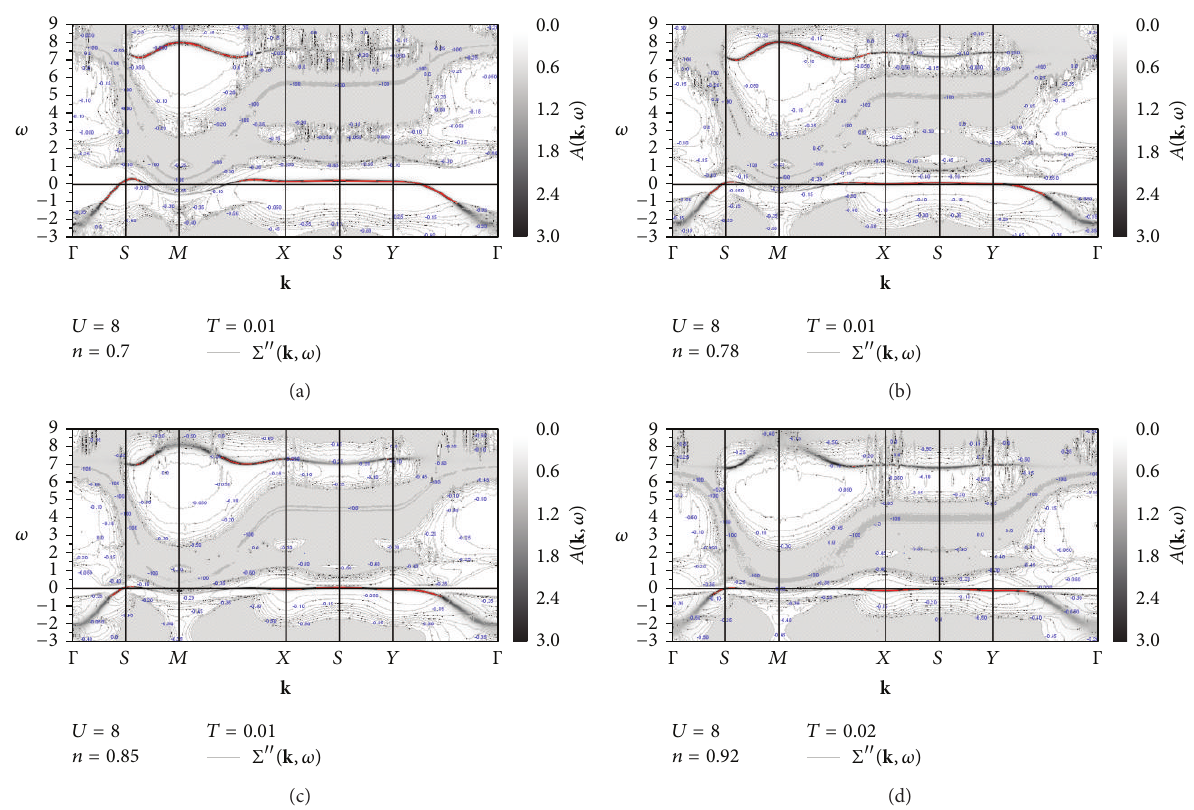
Figure 2: (Color online) Spectral function 𝐴( k ,𝜔) along the principal directions ( Γ = (0,0) → 𝑀 = (𝜋,𝜋) , 𝑀 → 𝑋 = (𝜋,0) , 𝑋 → 𝑌 = (0, 𝜋) and 𝑌 → Γ ) for 𝑈 = 8 , 𝑇 = 0.01 and (a) 𝑛 = 0.70 , (b) 𝑛 = 0.78 , (c) 𝑛 = 0.85 , and (d) 𝑛 = 0.92 ( 𝑇 = 0.02